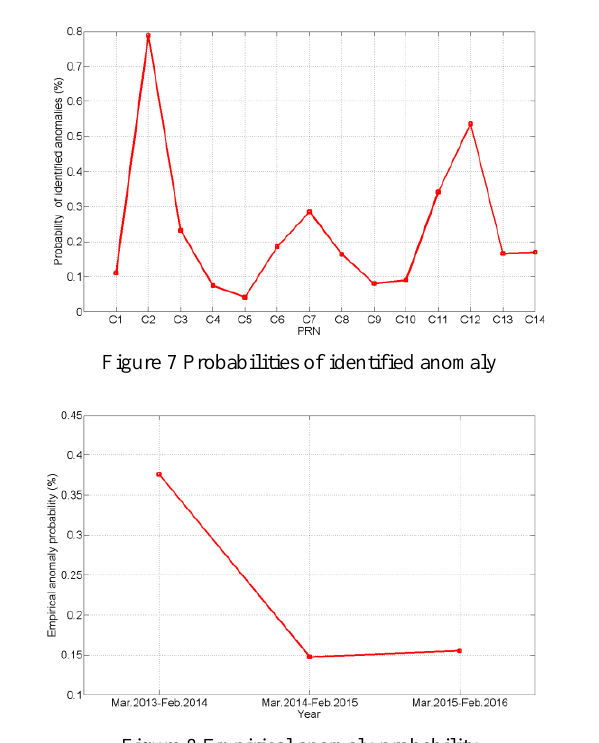
Figure 8 Empirical anomaly